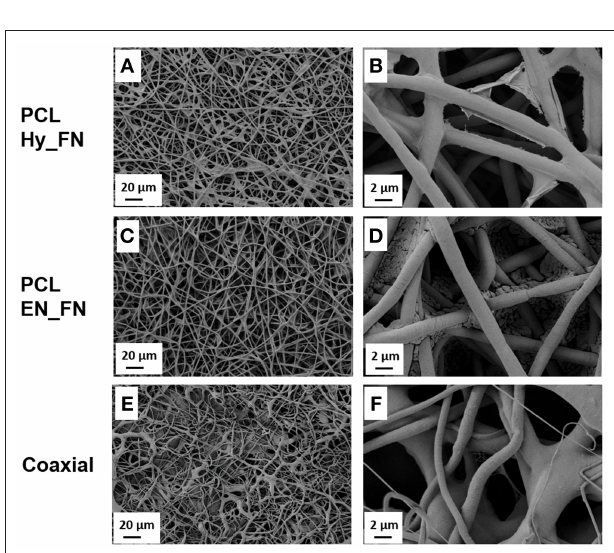
FIGURE 3 | SEM micrographs of PCL fibers before (A,B) , after hydrolysis and protonation (C,D) , and after EDC-NHS treatment (E,F) .